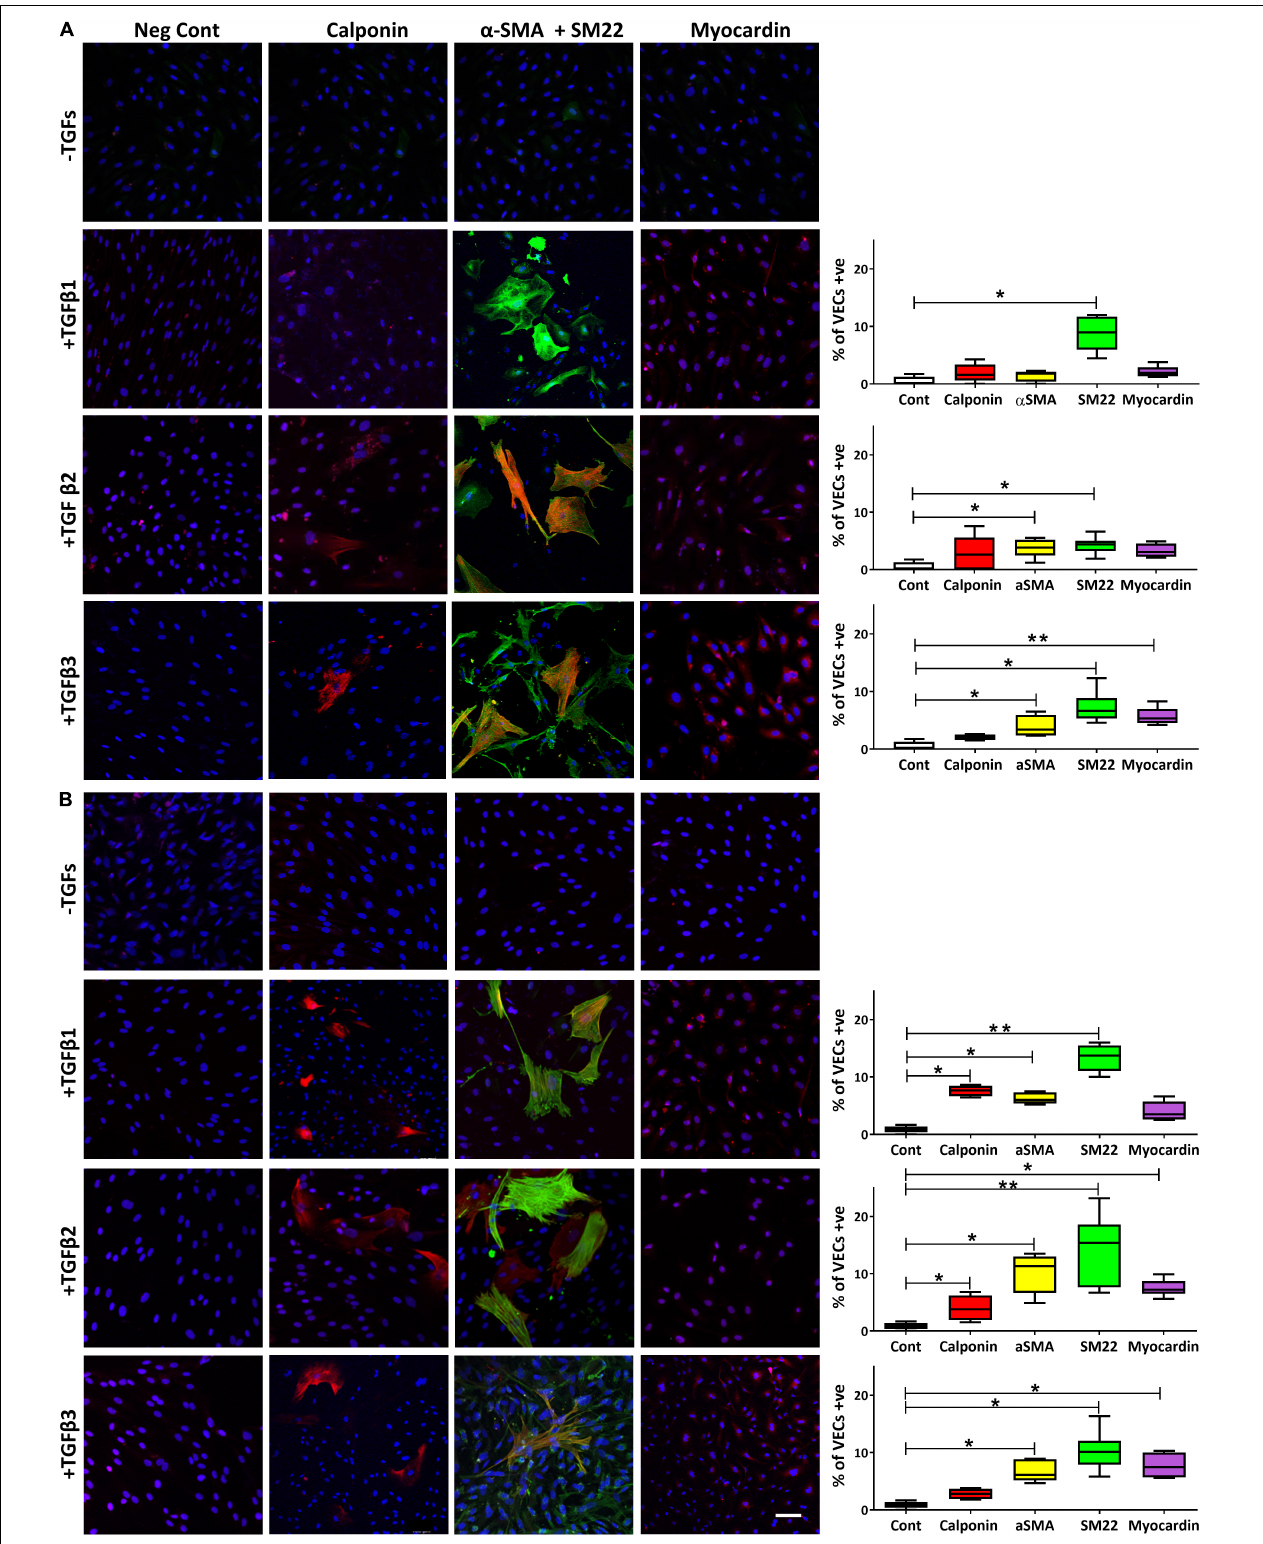
FIGURE 5 | The expression of calponin, α -SMA and SM22 merged, and myocardin in VECs plated on gelatin (A) and on fibronectin (B) and treated with TGFs. Scale bar represents 50 µ m. * p ,0.05, ** p < 0.01.